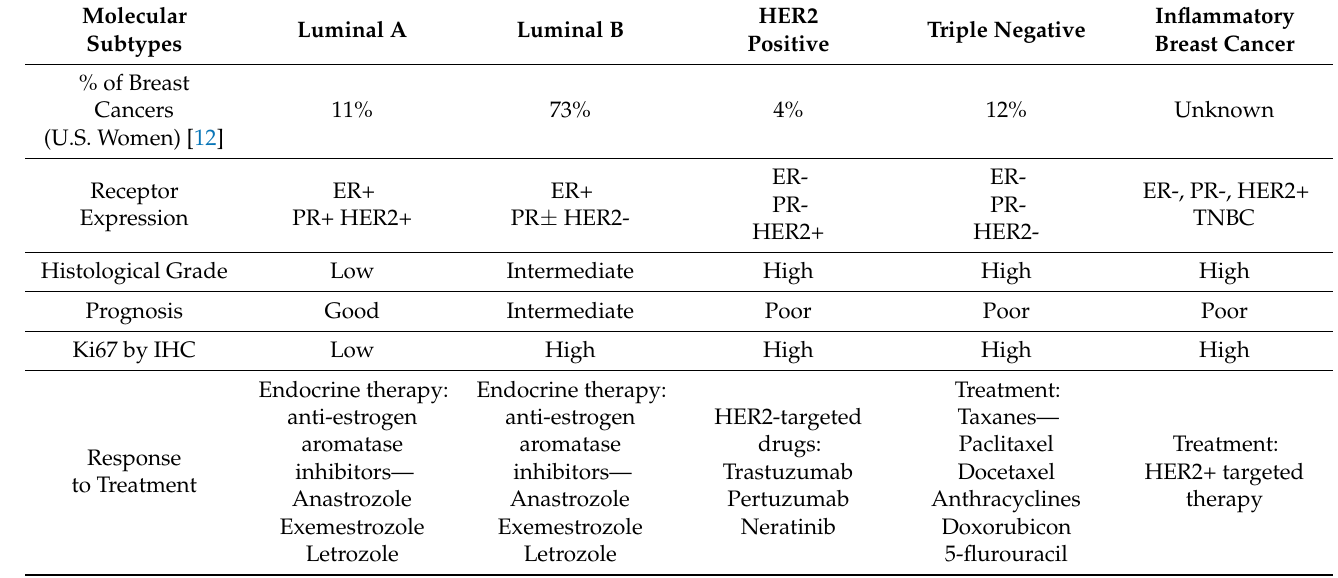
Table 1. Distinct features of breast cancer based on molecular histotypes for U.S.